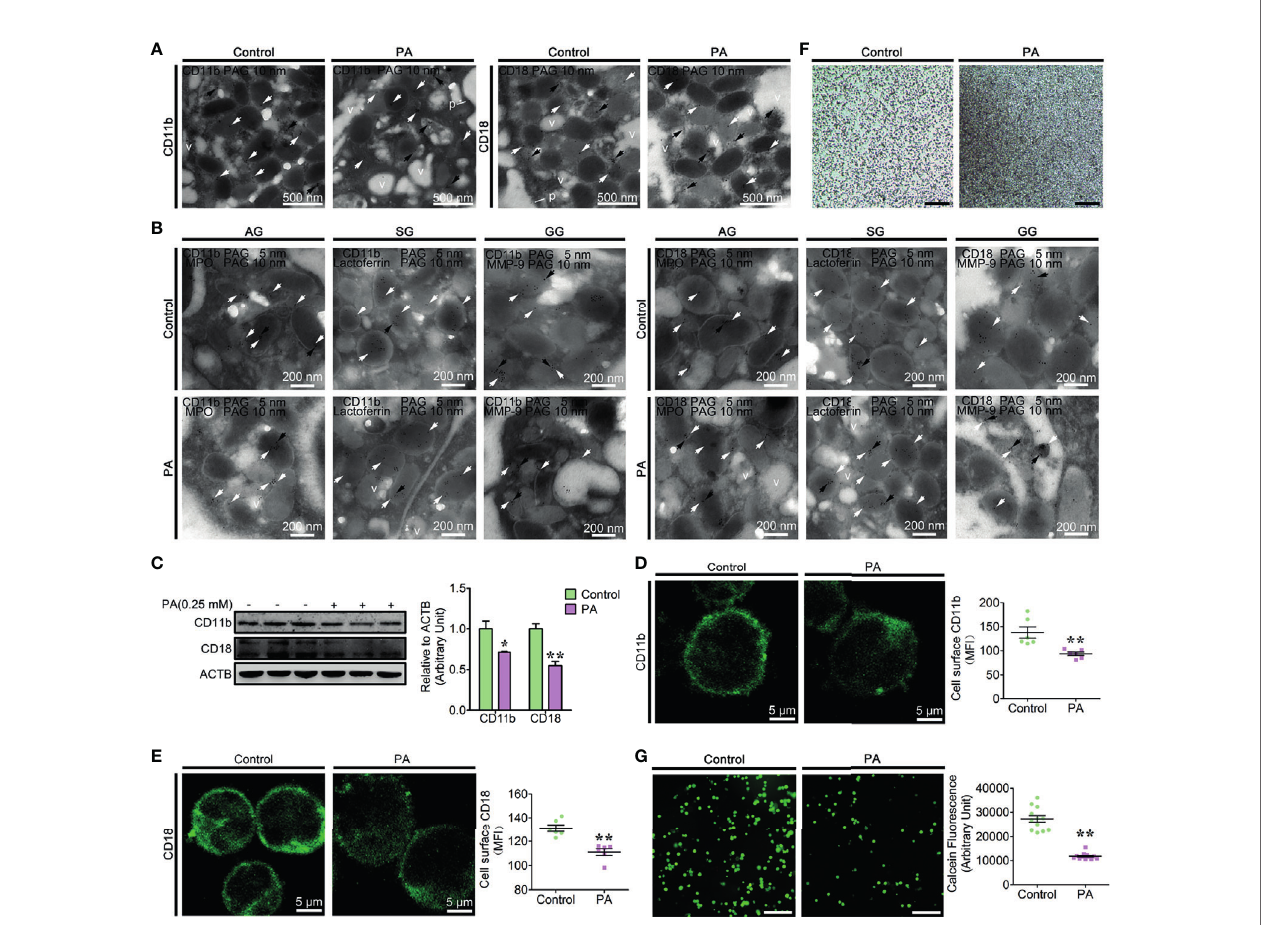
FIGURE 3 | Autophagy-mediated PA triggered the decrease of dairy cow neutrophil adhesion (A) Immunogold electron micrograph showing the localization of CD11b in control and PA-treated bovine neutrophils. White arrows show gold grains on the granules, black arrows show gold grains on AVi and AVd, and v shows gold grains on vacuoles. N, nucleus. p, plasma membrane. Scale bars as indicated. (B) Portion of immunogold electron micrographs of control and PA-treated bovine neutrophils labeled for MPO, lactoferrin, or MMP-9 (10-nm gold grains, black arrows) and then labeled for CD11b and CD18 (5-nm gold grains, white arrows). Scale bars as indicated. (C) Immunoblot for the total protein expression of CD11b and CD18 in control and PA-treated bovine neutrophils ( n = 3). Data represent the mean ± s.e.m. (* p < 0.05 and ** p < 0.01 versus the control group; signi fi cance calculated using two-way ANOVA). (D) Representative immuno fl uorescence images and fl ow cytometry analysis of the surface expression of CD11b on control and PA-treated bovine neutrophils ( n = 6). Data represent the mean ± s.e.m. (** p < 0.01 versus the control group; signi fi cance calculated using t -test). (E) Representative immuno fl uorescence images and fl ow cytometry analysis of the surface expression of CD18 on control and PA-treated bovine neutrophils ( n = 6). Data represent the mean ± s.e.m. (** p < 0.01 versus the control group; signi fi cance calculated using t -test). (F) Representative light microscopy images of control and PA-treated bovine neutrophils. Scale bar, 2 mm. (G) Representative fl uorescence micrograph images (left) and fl uorescence microplate analysis (right) of normal and fatty liver bovine neutrophils ( n = 6). Scale bar, 400 m m. Data represent the mean ± s.e.m. (** p < 0.01 versus the control group; signi fi cance calculated using t